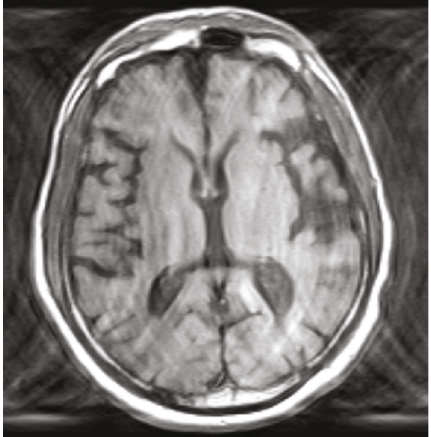
Figure 2: MRI of the brain showing the left parietal, insular, and lacunar infarct and